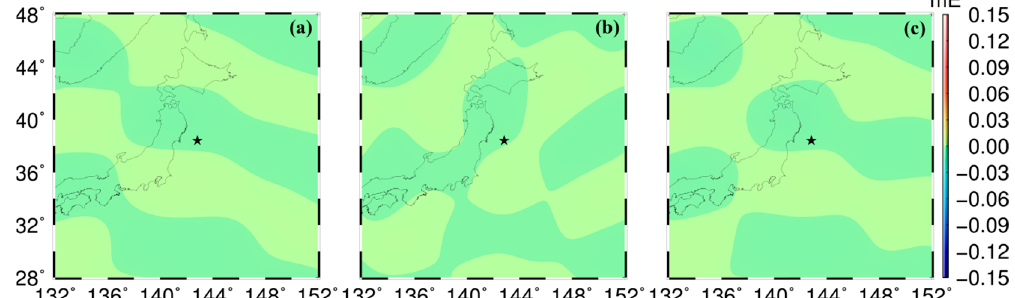
Figure 8. Radial gravity gradient changes ( Δ V zz ) in Local North-Oriented Frame on a sphere with a height of 260 km computed by the tailored spherical harmonic coefficients from GLDAS ( a ), ECCO-OBP ( b ) and both of GLDAS and ECCO-OBP ( c ) with a Gaussian filter applied. The SH degree range is 30–95 and the radius of the filter is 210 km. The units are mE.